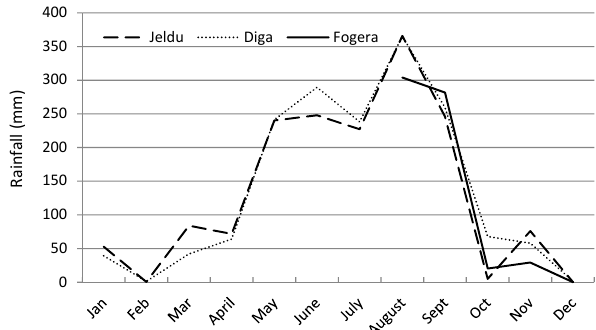
Figure 2. Rainfall of the study sites in 2011 with Fogera’s data only for August to